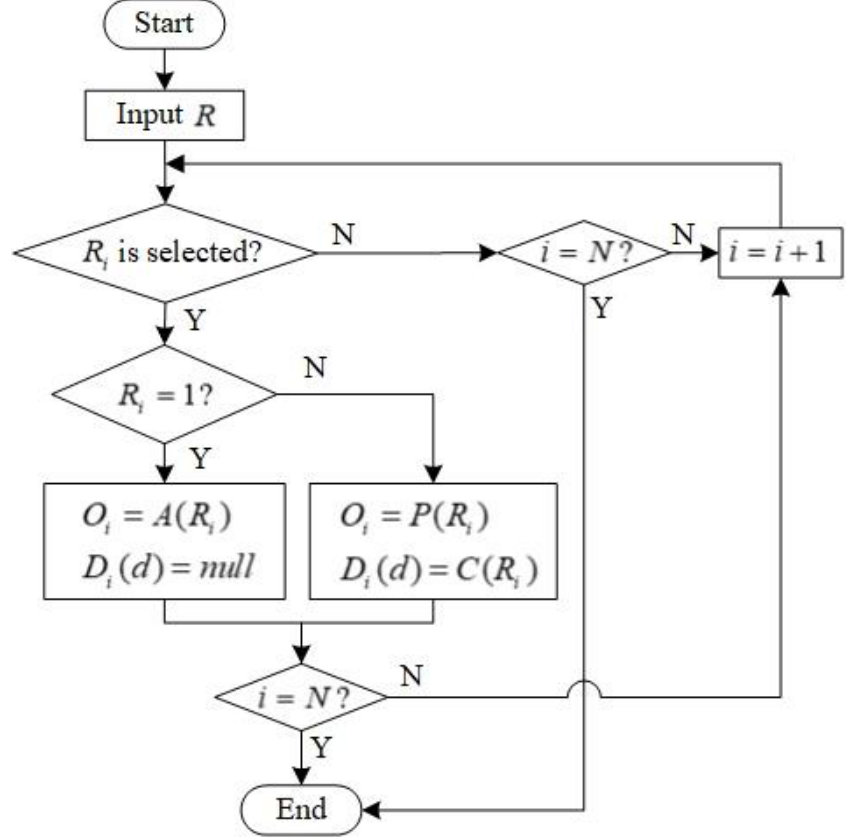
Figure 6. Flowchart of the coding principle and dictionary update rules.